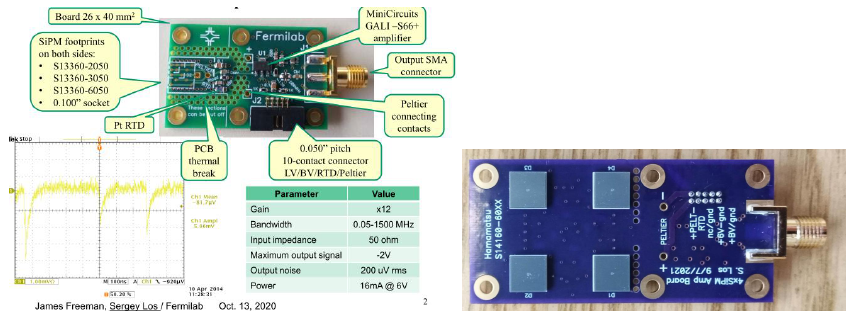
Figure 4. Single-sensor ( left ) and quadruple-sensor ( right ) FEE boards for ADRIANO2 light